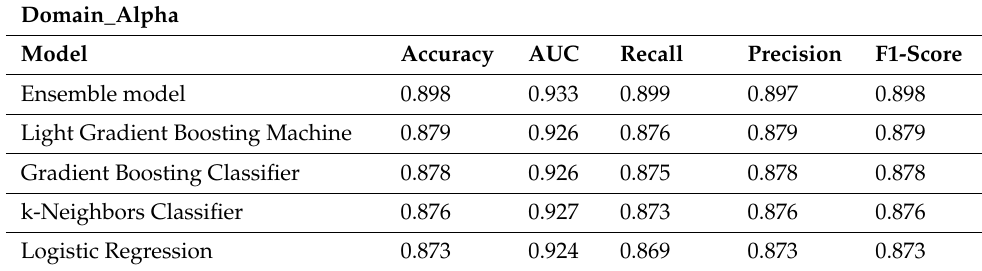
Table 7. Ensemble model for the Domain